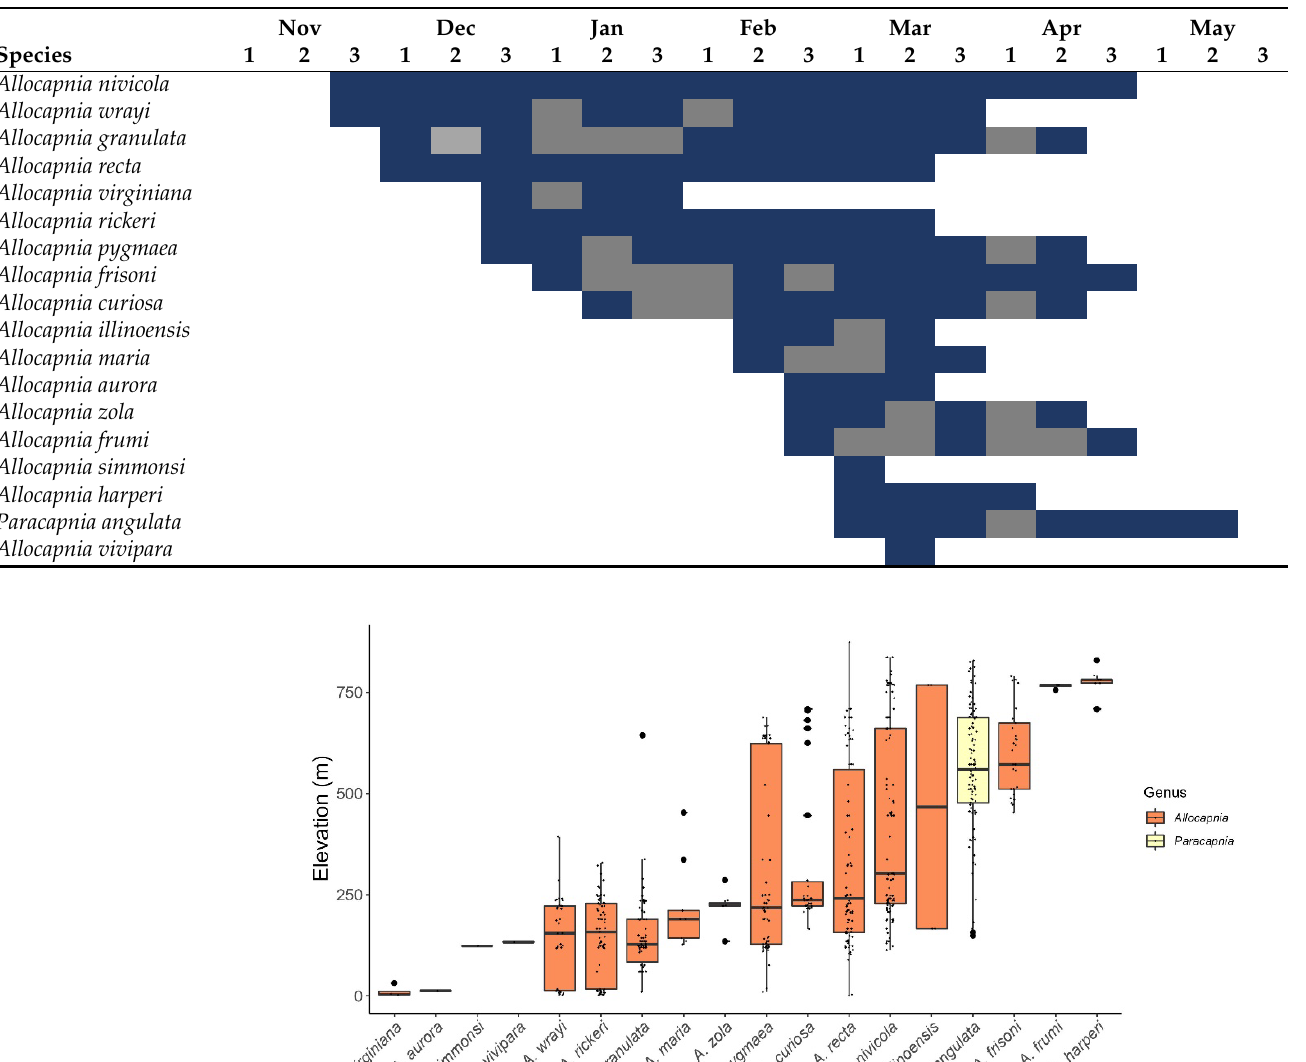
Table 4. Recorded adult Capniidae presence in Maryland. Months are broken into three 10-day periods. Dark blue squares represent periods with collections. Gray squares represent periods when species may be collected.